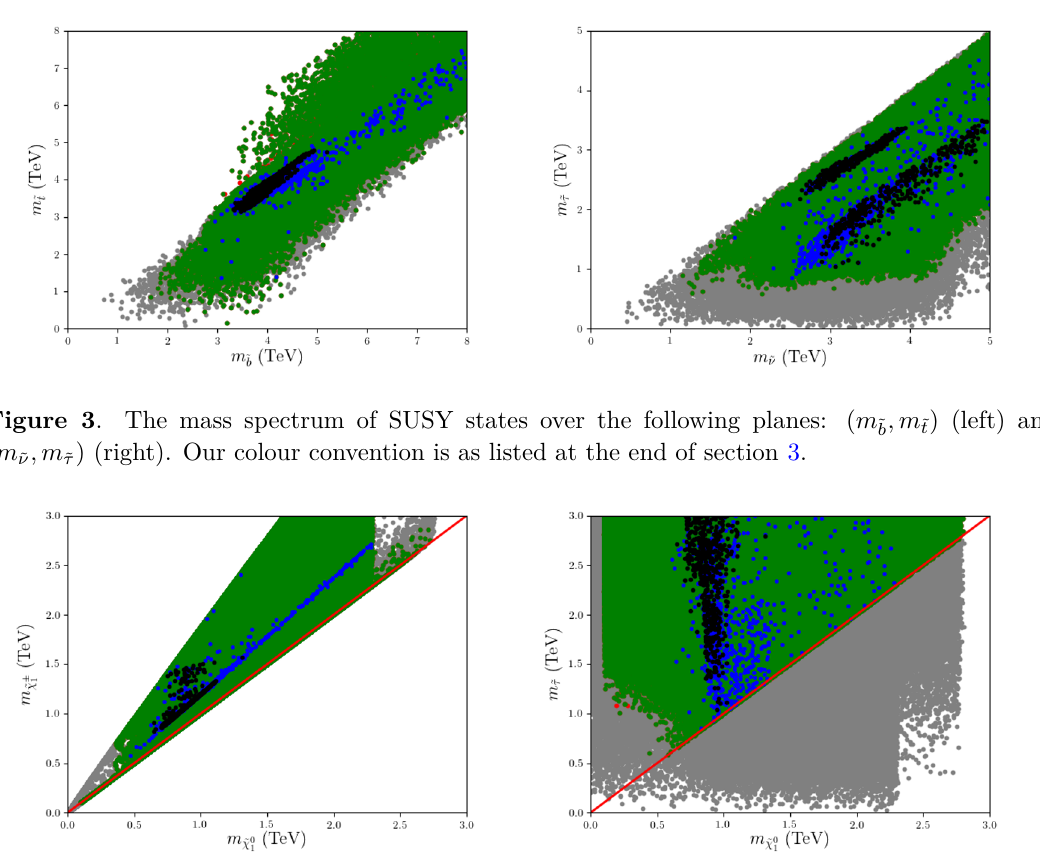
Figure 4 . The mass spectrum of the lightest neutralino and chargino and relic density channels over the following planes: ( m ) (top left), ( m , m , m ˜ τ ) (top right), ( m , m A ) (bottom left) ˜ χ 0 1 ˜ χ 0 1 ˜ χ 0 1 ˜ χ ± 1 and ( m , m H ) (bottom right). Our colour convention is as listed at the end of section 3. ˜ χ 0 1 a heavier range, 2 . 5 TeV . m . 5 TeV . According to our results, we also obtain ˜ b , m ˜ t